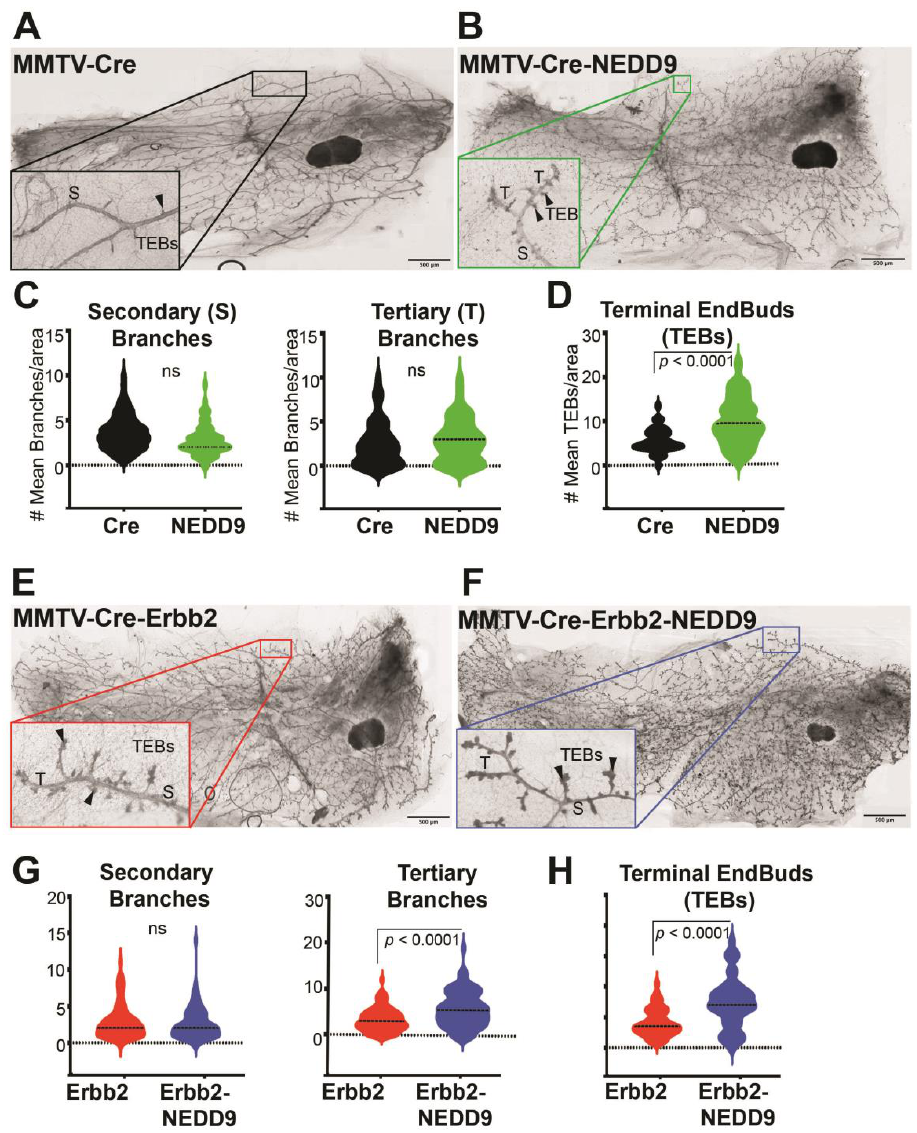
Figure 3. NEDD9 overexpression alters mammary gland architecture. ( A , B ) Representative images